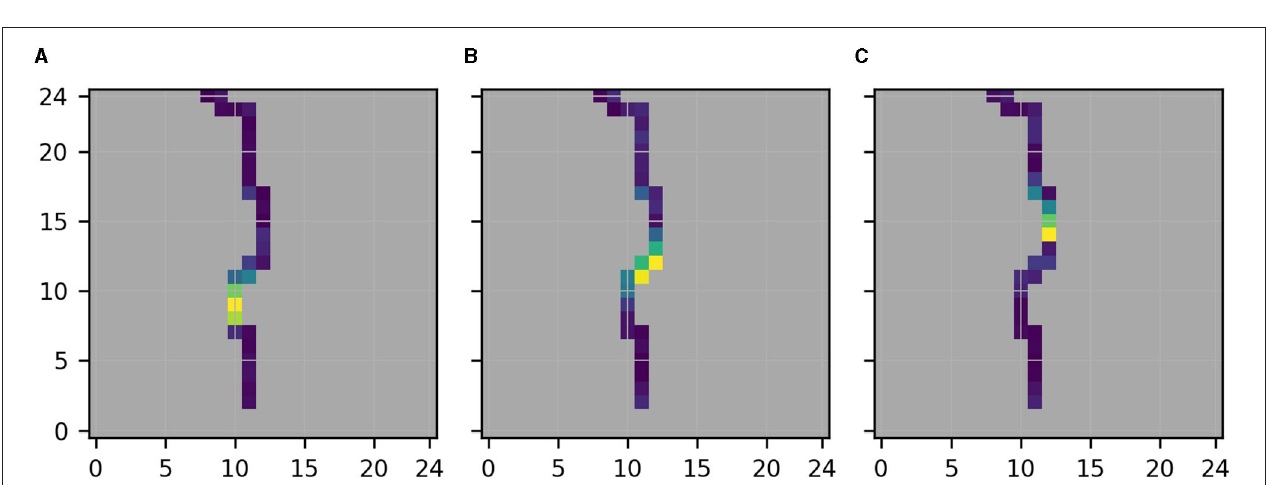
FIGURE 8 | Descriptions of the functions that separate instances of the MLP learned when trained for the different target locations [From left to right the target location is at (10,10), (12,12), (12,15), see Figure 2B ]. Note that (B) shows the same as Figure 7A . Gray marks pixels outside the considered river segment. (A) Lower target location. (B) Central target location. (C) Upper target